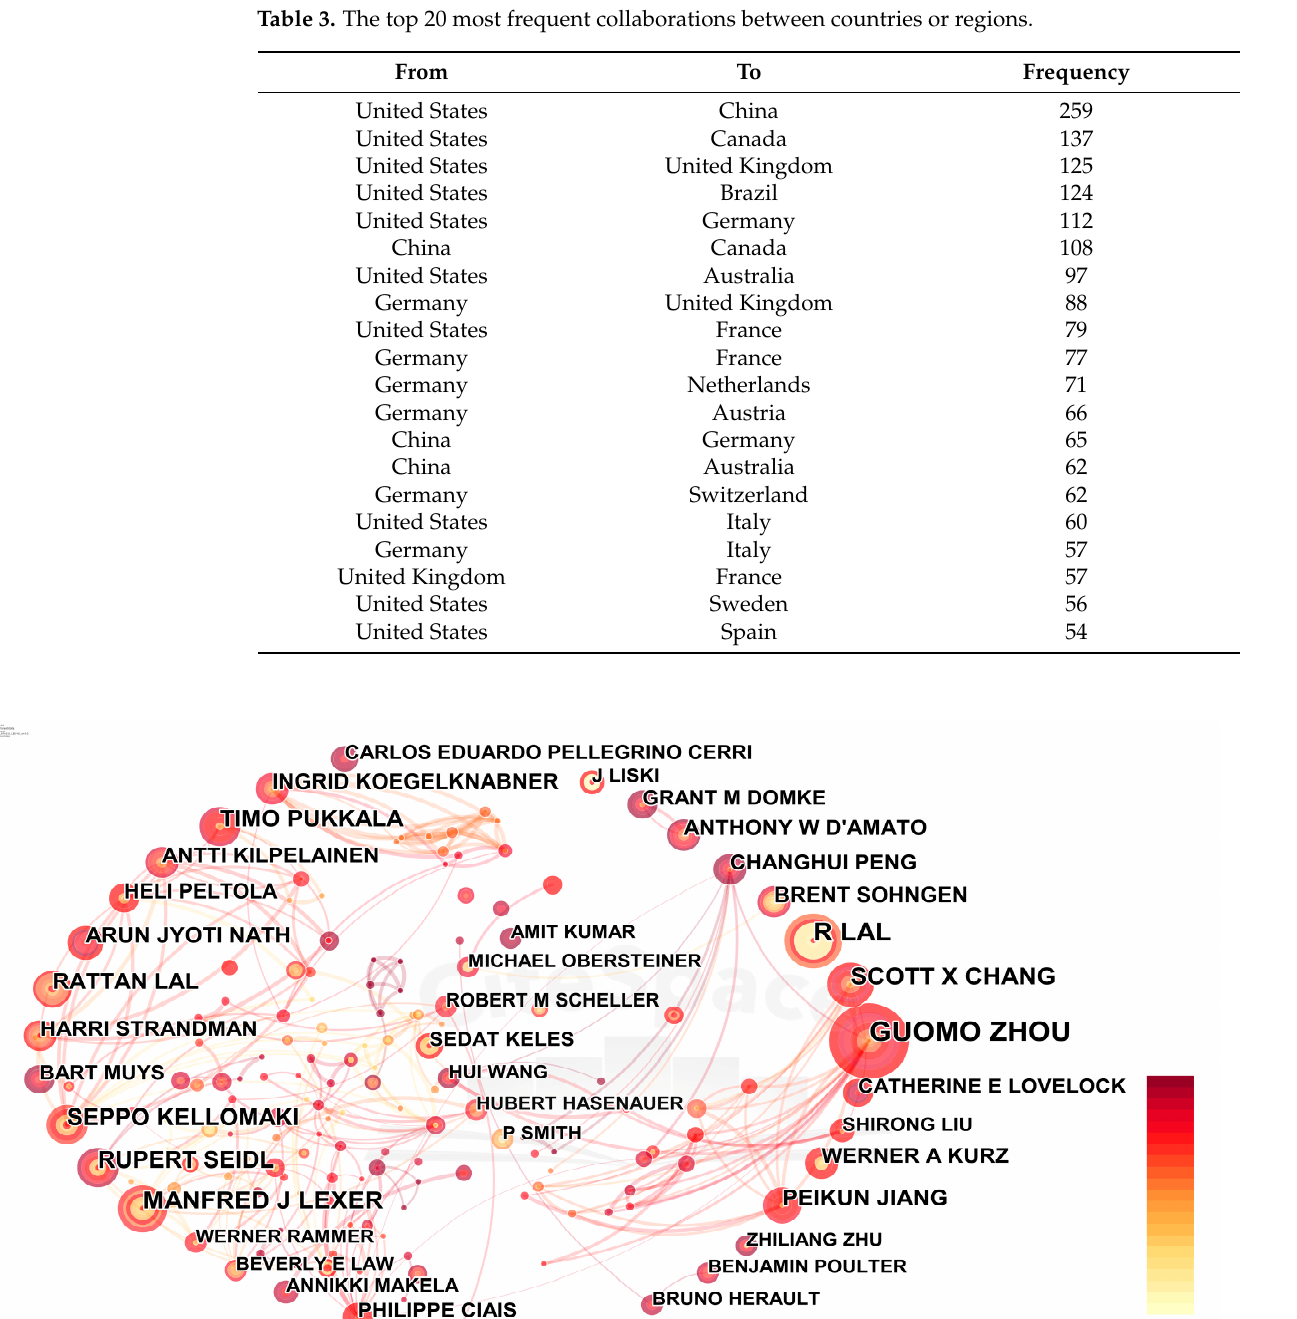
Table 3. The top 20 most frequent collaborations between countries or regions.